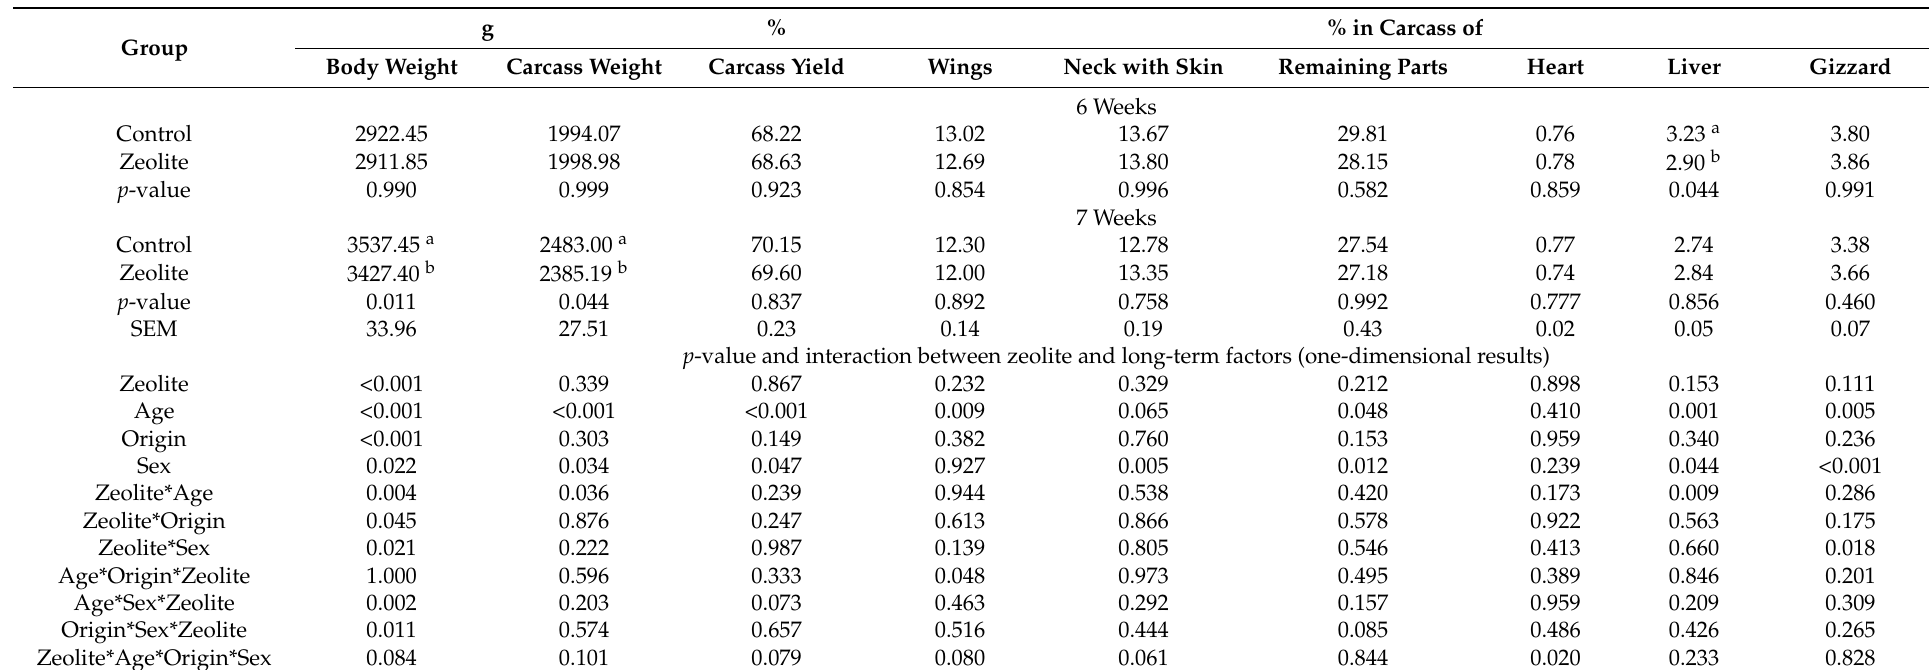
Table 4. Body weight and carcass traits in broiler ducks